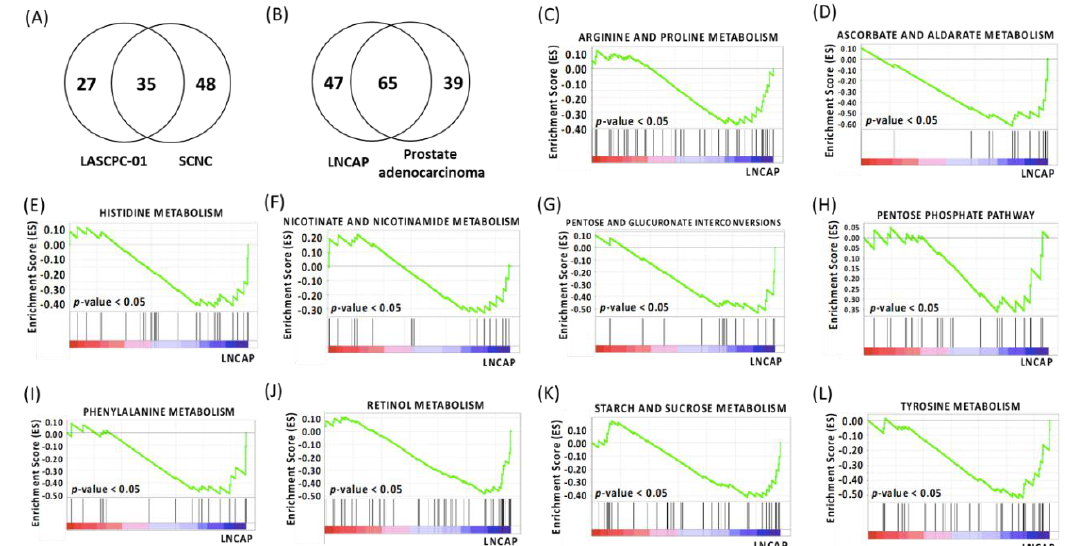
Figure 2. ( A ) Venn diagram of gene sets upregulated in both the LASCPC-01 cell line and patients with SCNC. ( B ) Venn diagram of gene sets upregulated in both the LNCAP cell line and patients with prostate adenocarcinoma . ( C ) Gene set enrichment (GSEA) plot depicting the enrichment of genes upregulated in arginine and proline metabolism in the LNCAP cell line ( p -value < 0.05). ( D ) GSEA plot depicting the enrichment of genes upregulated in ascorbate and aldarate metabolism in the LNCAP cell line ( p -value < 0.05). ( E ) GSEA plot depicting the enrichment of genes upregulated in histidine metabolism in the LNCAP cell line ( p -value < 0.05). ( F ) GSEA plot depicting the enrichment of genes upregulated in nicotinate and nicotinamide metabolism in the LNCAP cell line ( p -value < 0.05). ( G ) GSEA plot depicting the enrichment of genes upregulated in pentose and glucuronate interconversions pathway in the LNCAP cell line ( p -value < 0.05). ( H ) GSEA plot depicting the enrichment of genes upregulated in pentose phosphate pathway in the LNCAP cell line ( p -value < 0.05). (I) GSEA plot depicting the enrichment of genes upregulated in phenylalanine metabolism in the LNCAP cell line ( p -value < 0.05). ( J ) GSEA plot depicting the enrichment of genes upregulated in retinol metabolism in the LNCAP cell line ( p -value < 0.05). ( K ) GSEA plot depicting the enrichment of genes upregulated in starch and sucrose metabolism in the LNCAP cell line ( p -value < 0.05). ( L ) GSEA plot depicting the enrichment of genes upregulated in tyrosine metabolism in the LNCAP cell line ( p -value < 0.05). Table 1. Upregulated gene sets involved in the metabolism of polar metabolites in the LASCPC-01 cell line and SCNC patients. Gene Sets Number ES p- value